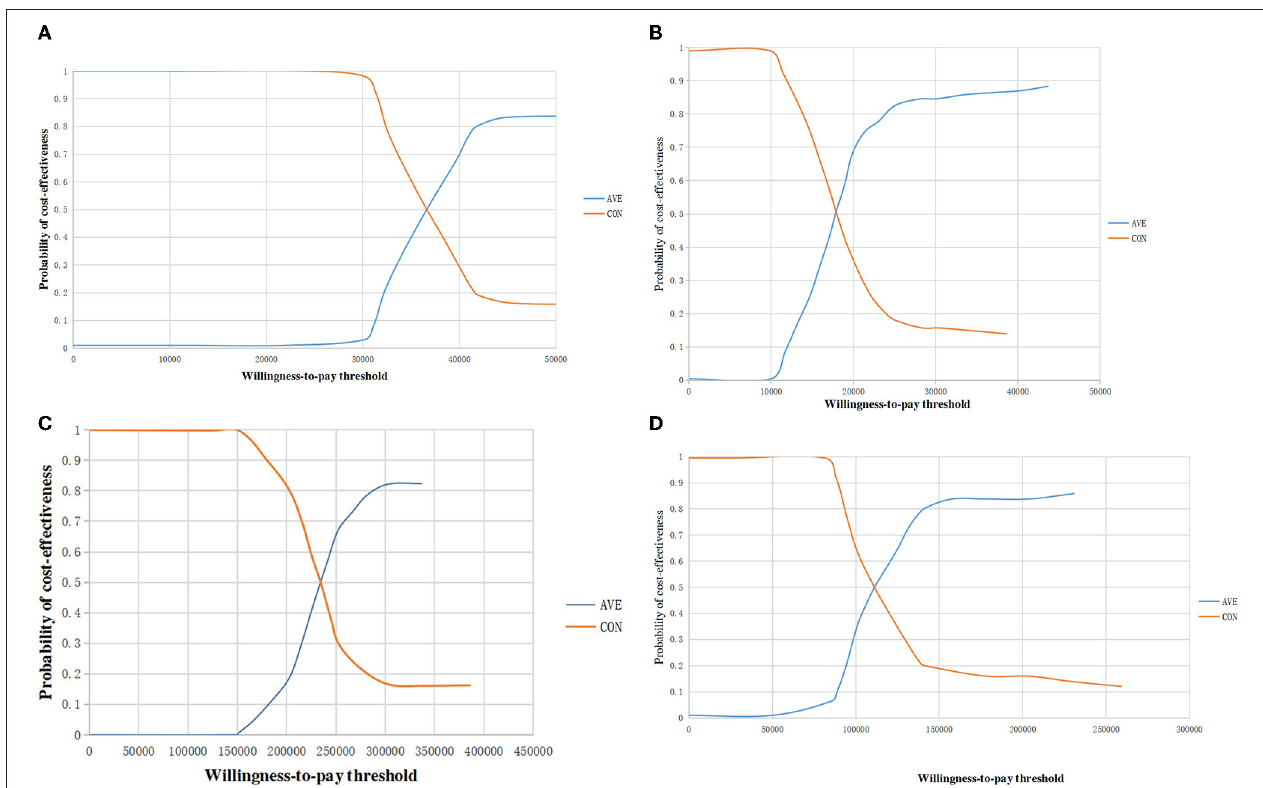
FIGURE 4 | The acceptability curve of cost-effectiveness showed the probability at current WTP threshold. (A) The overall population in the US; (B) The PD-L1–positive population in the US; (C) The overall population in China; (D) The PD-L1–positive population in China. WTP, willingness to pay; QALYs, quality-adjusted life